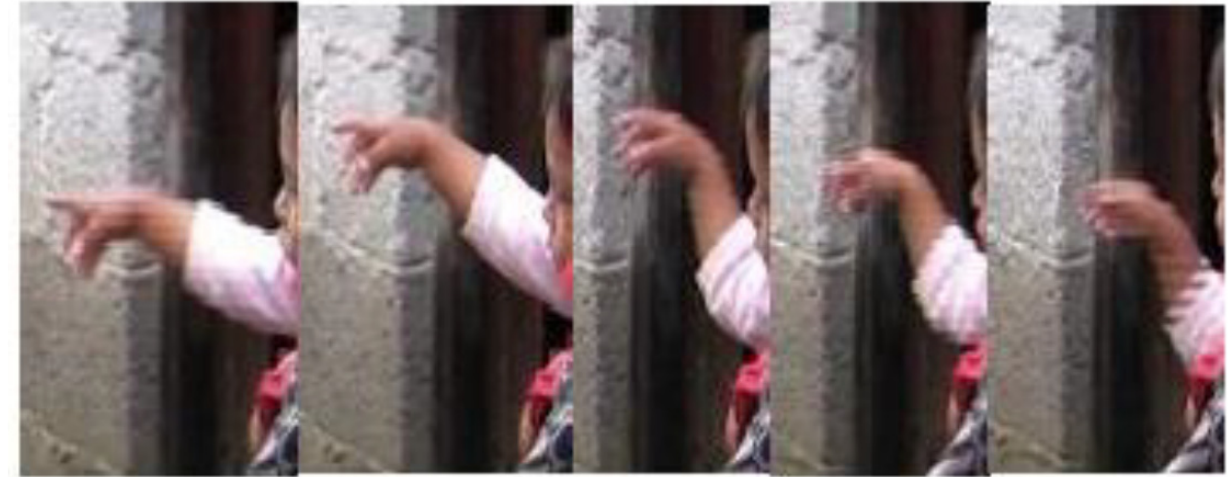
Figure 10. Vic’s extended index figure seem to give way to a little wave.